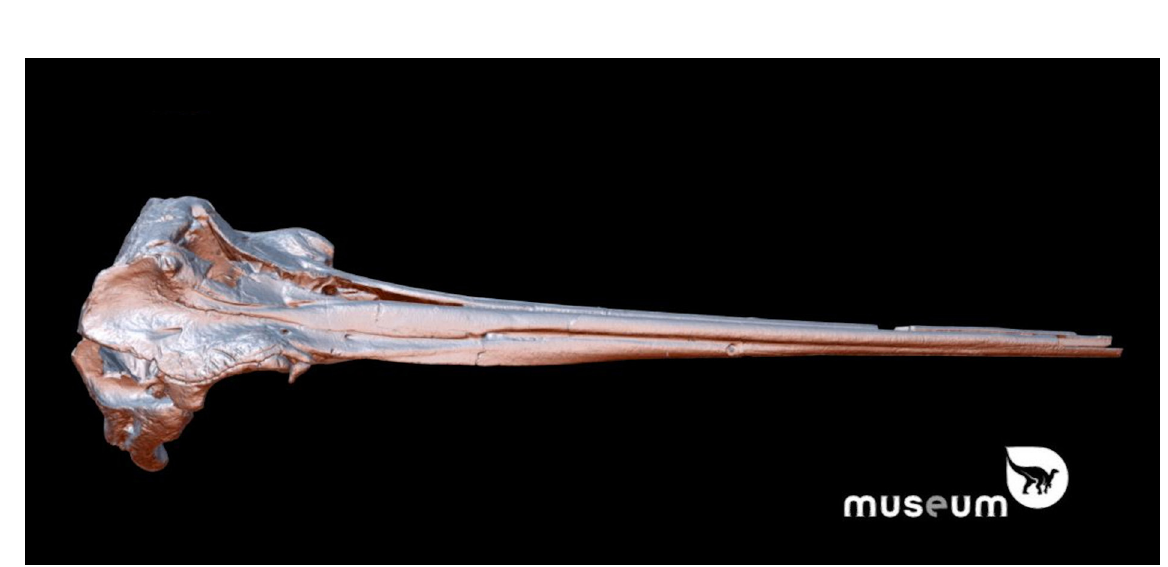
Fig. 3.25. Type specimen of Eurhinodelphis cocheteuxi , from the early to middle Miocene. Skull length 1074 mm. Scanned with HDI.